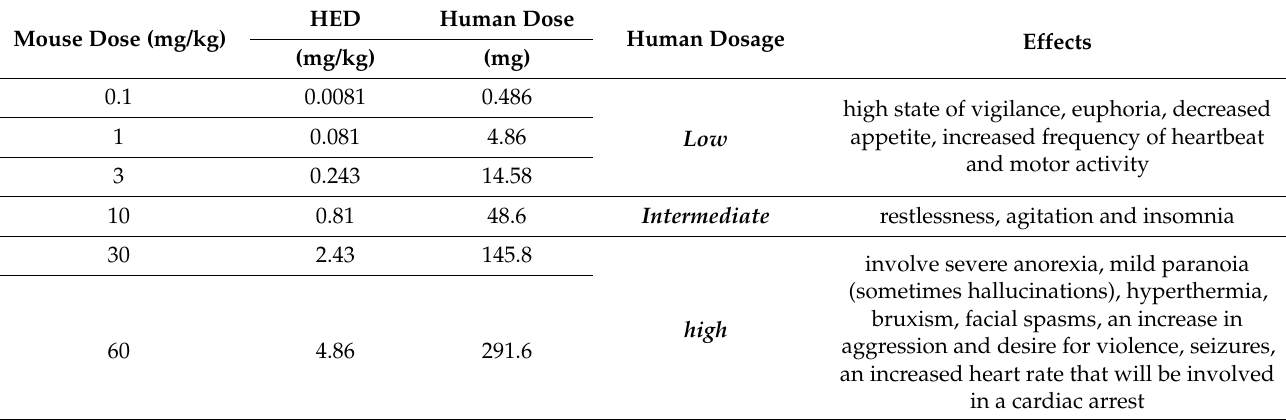
Table 5. Correlation between mouse doses (mg/kg) and human equivalent doses (HED, mg/kg). The table also reported the correlation between doses and effects in human. Mouse Dose